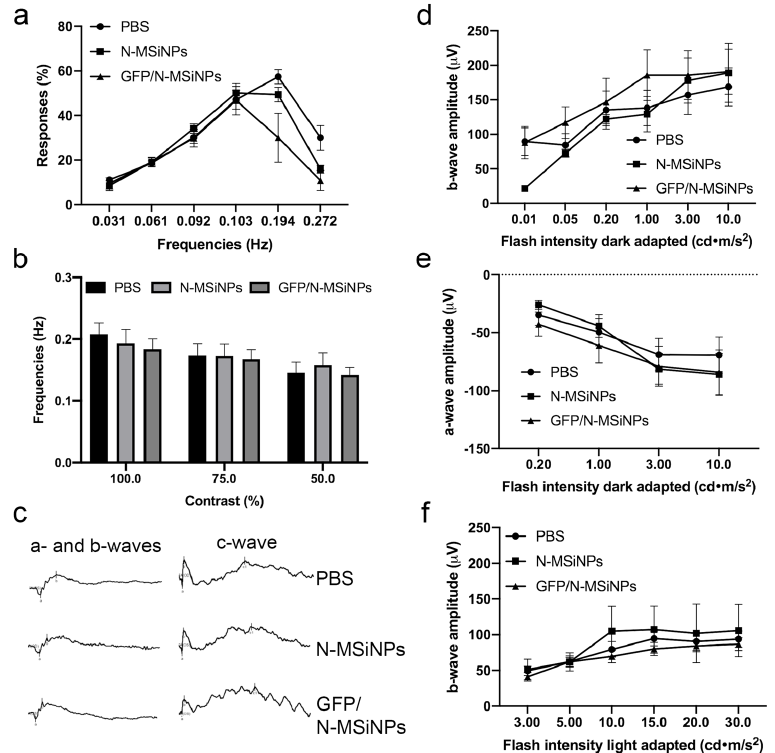
Figure 4. Functional evaluation of mouse retinas three months after subretinal injection of 1 µL PBS, empty nanoparticles (N-MSiNPs), or nanoparticles loaded with the pEGFP-N1 plasmid (GFP/N-MSiNPs). ( a ) Visual acuity measured by optomotor test at 100% contrast sensitivity. Values in ( a ) represent percentages of optokinetic responses ± SEM at different spatial frequencies ( n = 6). ( b ) Contrast perception threshold measured at 100%, 75%, and 50% contrast sensitivity. Bars in ( b ) represent the highest spatial frequencies in which optokinetic responses were visualized ± SEM. ( c ) Representative ERG traces observed in injected mice. The electrical activity of photoreceptors (a-and b-waves) and RPE (c-wave) are shown. ( d , e ) Quantification of the amplitude of the ERG b-wave and a-wave in scotopic conditions (dark-adapted), reflecting the rod and cone/rod activity, respectively. ( f ) Quantification of the amplitude of the ERG b-wave in photopic conditions (light-adapted), reflecting the activity of cone photoreceptors. Values in ( d – f ) represent wave amplitude in µV ± SEM at different flash intensities.